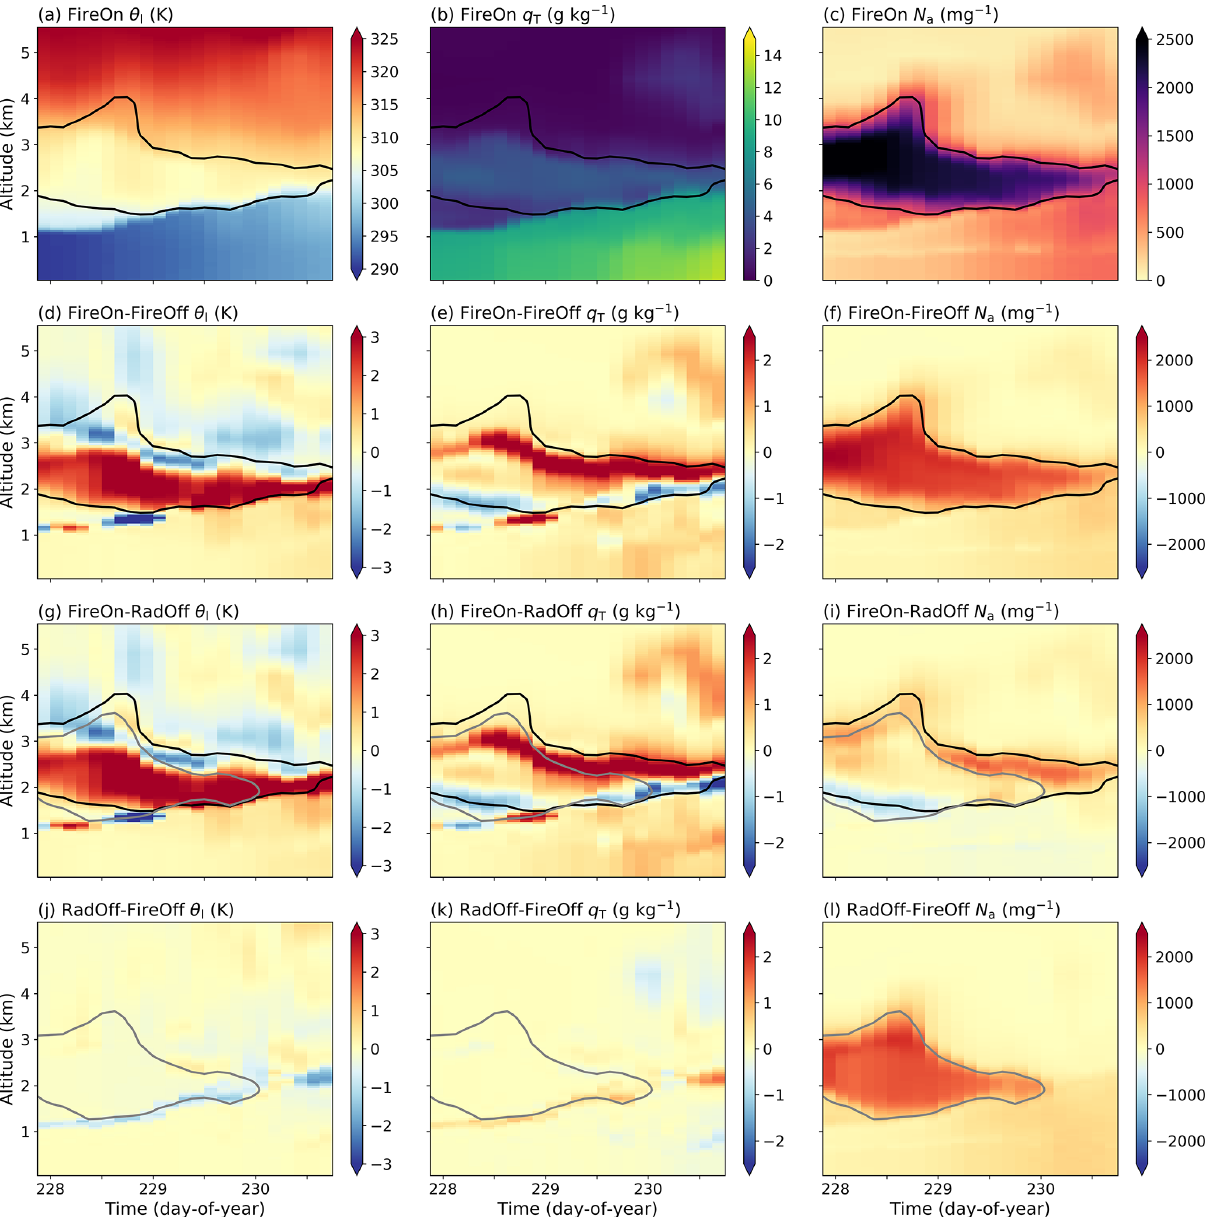
Figure 5. Lagrangian curtains of liquid water potential temperature, total water mixing ratio, and accumulation-mode aerosol number concentration from 20:00UTC on 15 August 2017 (doy 227) to 20:00UTC on 18 August 2017 (doy 230). Panels (a)–(c) show the FireOn case alone, (d)–(f) show the FireOn–FireOff difference, (g)–(i) show the FireOn–RadOff difference, and (j)–(l) show the RadOff–FireOff difference. Black contours indicate FireOn N a of 1000mg − 1 and grey contours indicate RadOff N a of 1000mg − 1